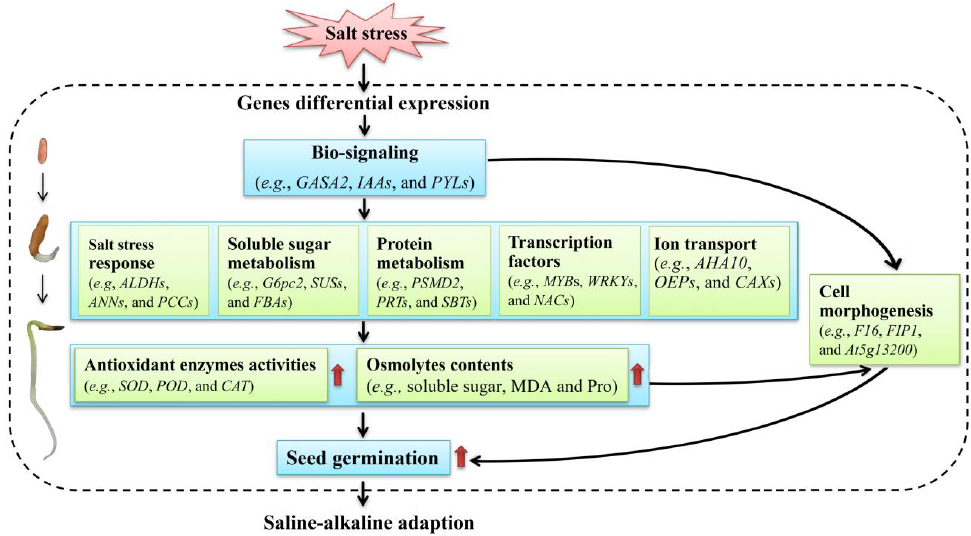
Figure 13. A proposed model of the low-salt-stress-enhanced seed germination of A. venetum